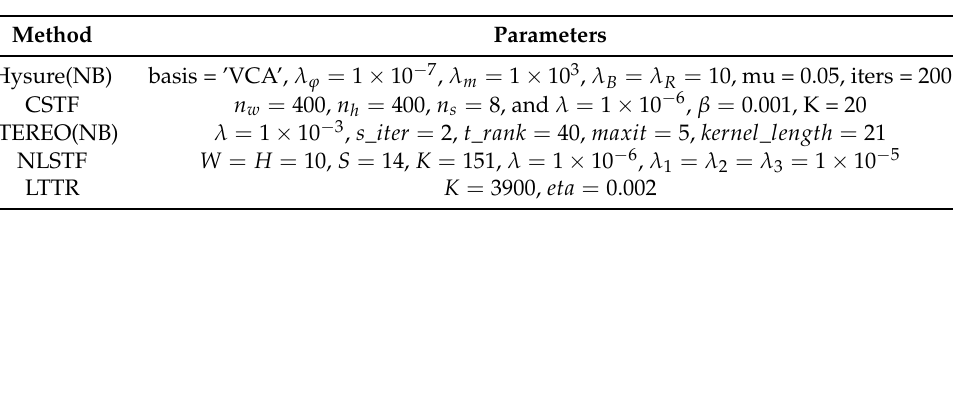
Table 1. Parameters of non-blind methods on the Pavia University data